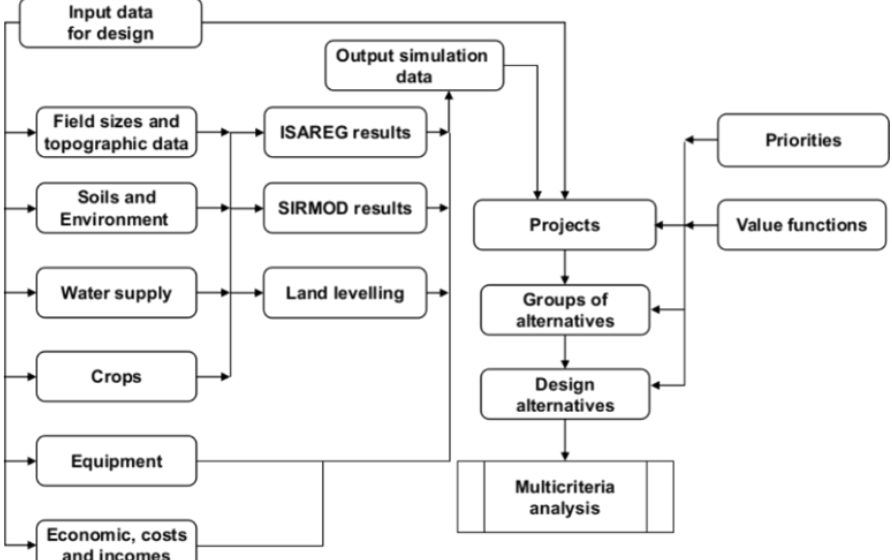
Figure 1. Irrigation Modeling components (Gonçalves and Pereira,